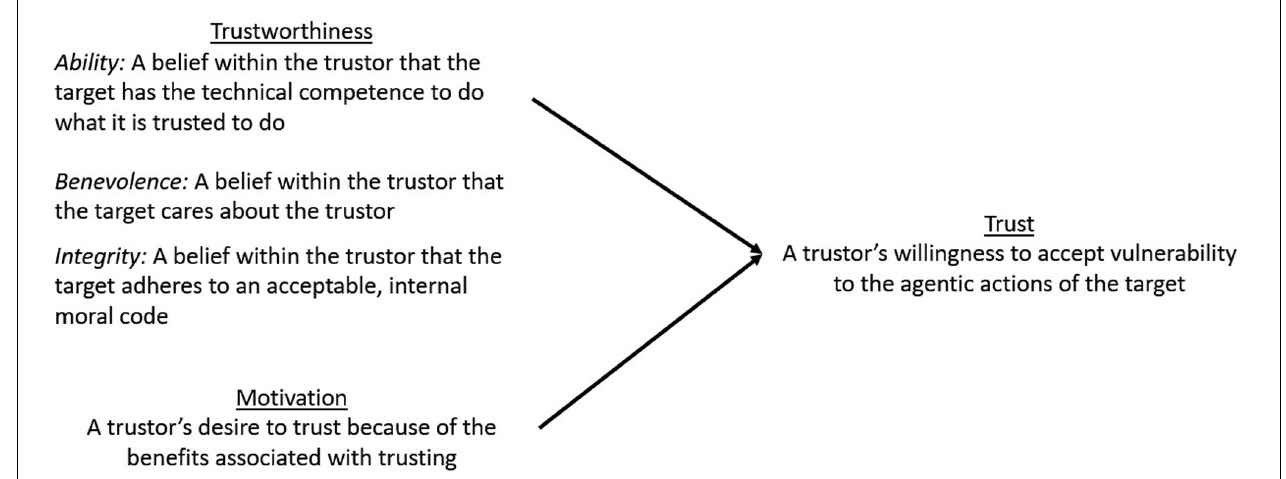
FIGURE 1 | Conceptual model of trust antecedents.